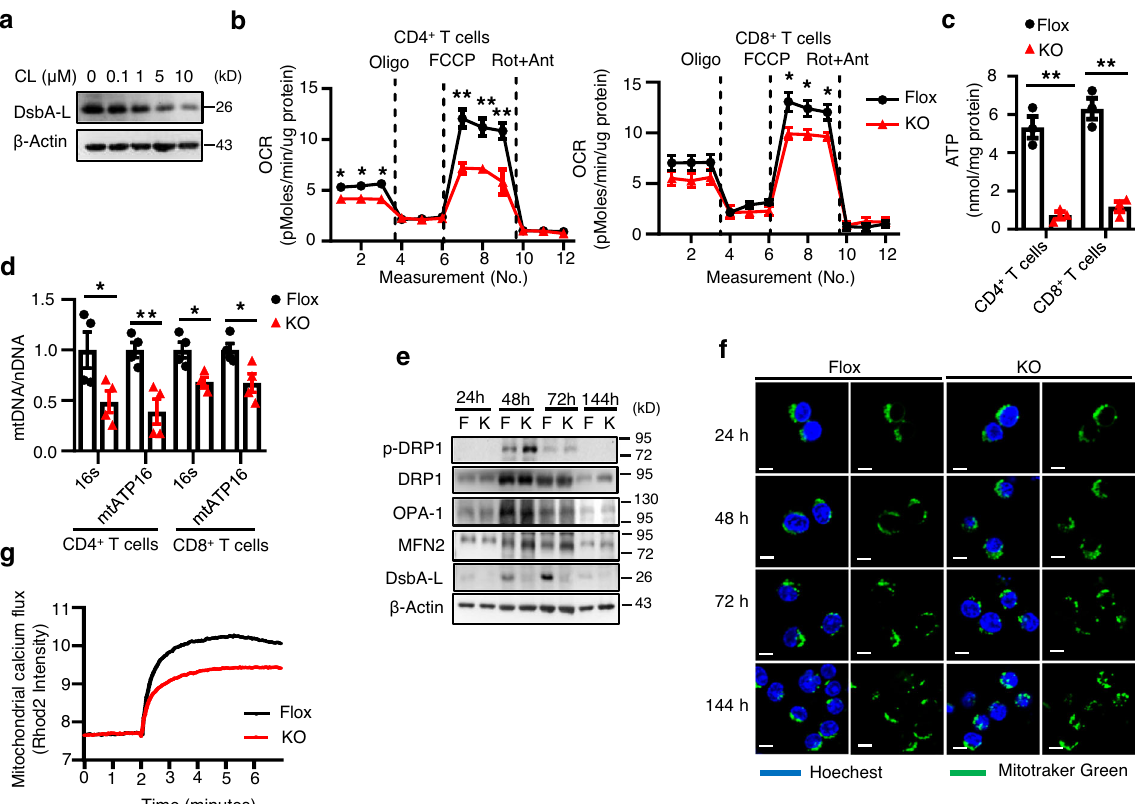
Fig. 2 DsbA-L is a critical regulator of T cell mitochondrial function. a DsbA-L expression in CD3 + T cells stimulated with different concentrations of CL316,243 for 24h. b OCR of CD4 + ( n = 5/group) and CD8 + ( n = 4 – 5/group) T cells were measured under basal conditions and in response to indicated drugs. Oligo, oligomycin; Rot, rotenone; Ant, antimycin. c ATP production of activated CD4 + ( n = 3/group) and CD8 + ( n = 3/group) T cells isolated from the spleen of DsbA-L CD4-KO mice and control littermates. d The relative mtDNA content in activated CD4 + ( n = 4/group) and CD8 + ( n = 4/group) T cells isolated from the spleen of DsbA-L CD4-KO mice and control littermates. e Mitochondrial fi ssion and fusion in activated CD4 + T cells isolated from the spleen of DsbA-L CD4-KO mice and control littermates were measured by western blot analyses. f Mitochondrial morphology was evaluated at indicated time points using live-cell confocal microscopy after staining with 100 nM Mito-Tracker Green and 10 μ g/ml Hoechst 33342. Scale bars: 5 μ m. g Mitochondrial calcium fl ux was measured in activated CD4 + T cells isolated from the spleen of DsbA-L CD4-KO mice and control littermates. Results are representative of three independent experiments. Data shown are representative of three independent experiments. All data are presented as mean ± SEM. Statistical values p < 0.05 (*), p <0.01 (**), p <0.001 (***) are determined by two-tailed unpaired Student ’ s t -test. Source data are provided as a Source Data